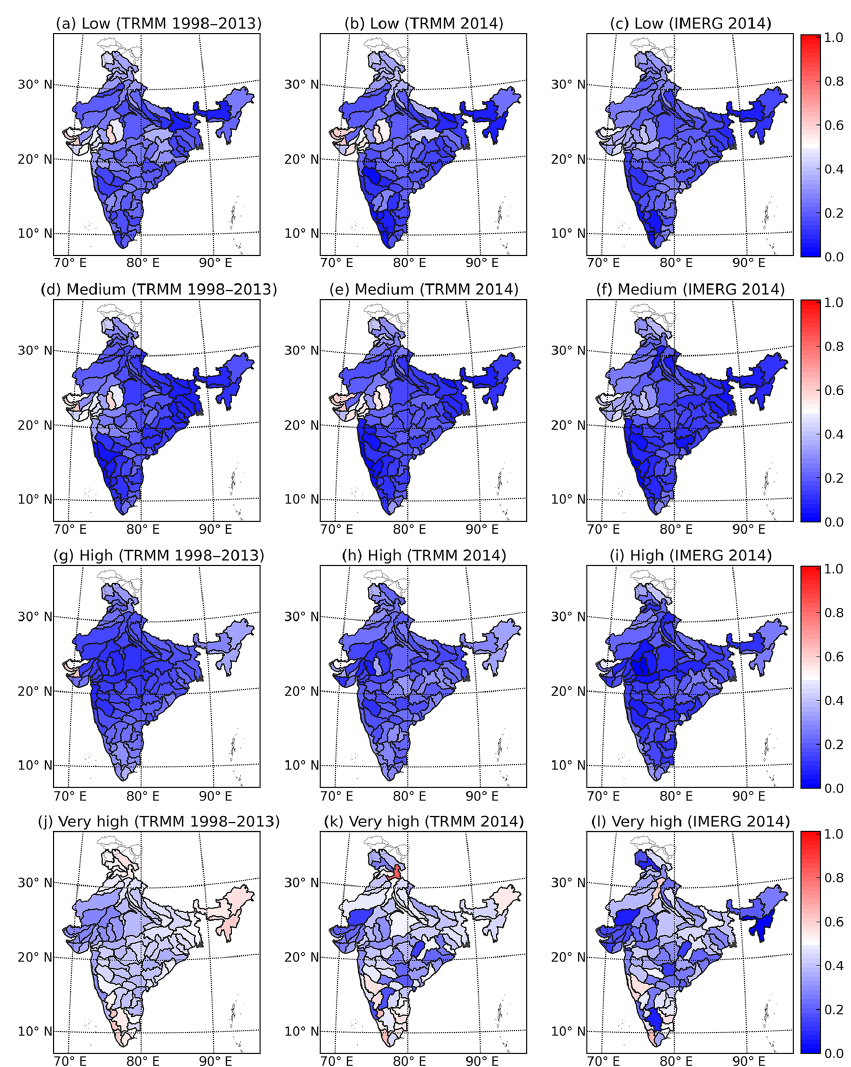
Figure 8. Spatial representation of false alarm ratio (FAR) for (a–c) low (25 percentile), (d–f) medium (50 percentile), (g–i) high (75 percentile) and (j–l) very high (95 percentile) rainfall threshold for TRMM 1998–2013, TRMM 2014 and IMERG 2014 rainfall estimates over 86 delineated river basins across